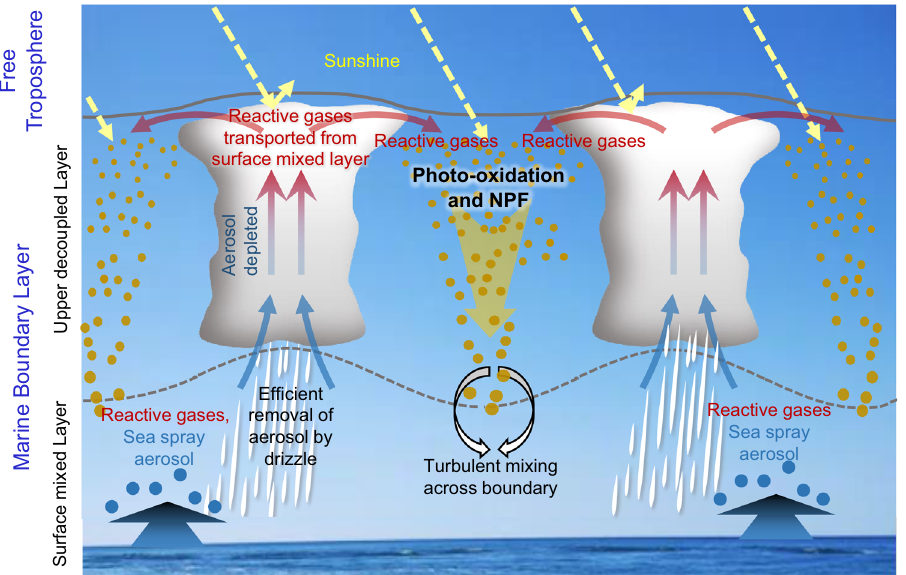
Fig. 3 Mechanism of new particle formation in a decoupled marine boundary layer when clouds form open cell convection or exhibit a scattered cloud fi eld following the passage of a cold front. In a decoupled marine boundary layer, particles and ocean-emitted trace gases are transported upwards from the surface mixed layer to the upper decoupled layer through rising thermals that form cumulus clouds. Cumulus-associated drizzle and precipitation ef fi ciently remove large particles and thus reduce existing aerosol surface area, while reactive gases of low water solubility survive and are detrained into the upper decoupled layer. In the clear region between clouds, these reactive gases undergo more rapid photo-oxidation and produce nucleation precursors, leading to new particle formation. The newly formed particles are subsequently mixed down to the surface layer through turbulent